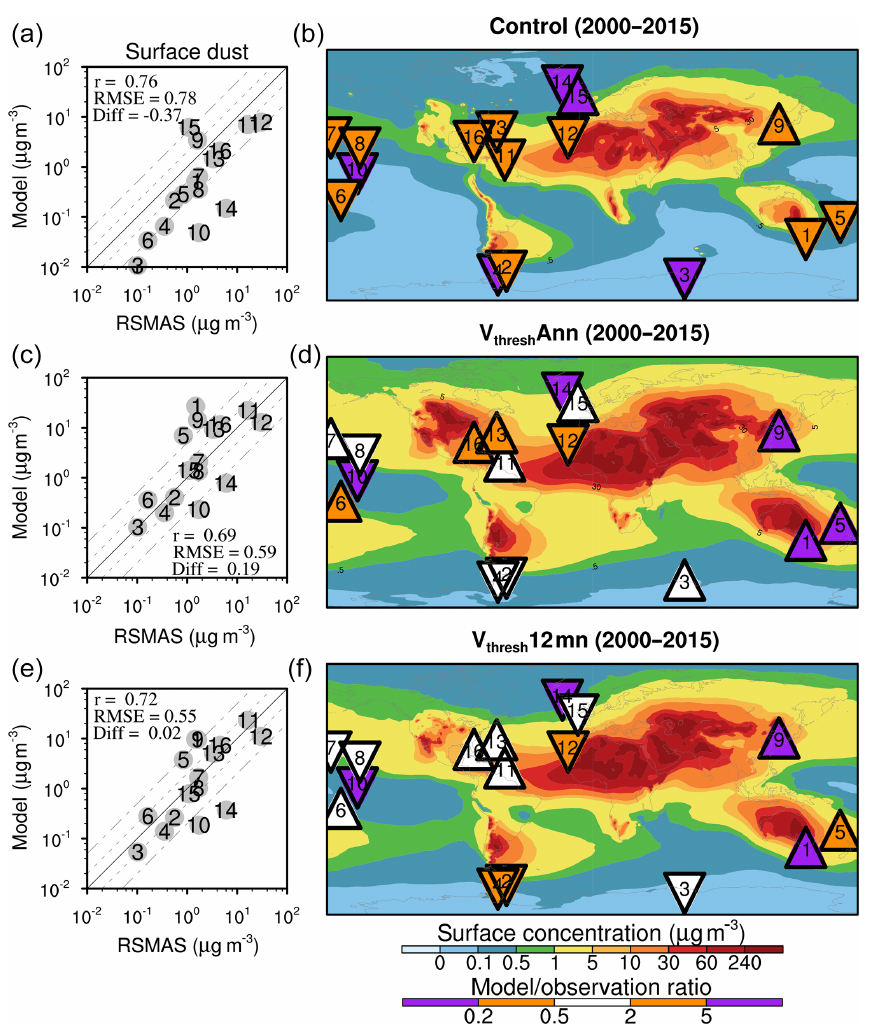
Figure 9. Scatter plots (a, c, e) of model simulated (from top to bottom are the Control, V thresh Ann, and V thresh 12mn simulations) surface dust concentration (µgm − 3 ) versus the climatology of observed surface dust concentration from RSMAS stations (Savoie and Prospero, 1989). Spatial pattern of surface dust concentration from model output (shading; b , d , f ) and the ratio between modeled and RSMAS station observed surface dust concentration (color triangles, with upward triangles indicating overestimation and downward triangles indicating underestimation). A total of 16 stations were used, and the numbers in each triangle (b, d, f) and grey dots (a, c, e) indicate the stations. The one–one, one–two, and one–five lines are plotted in solid, dashed, and dash-dotted lines in the scatter plots. Statistics in the scatter plots are calculated in logarithmic